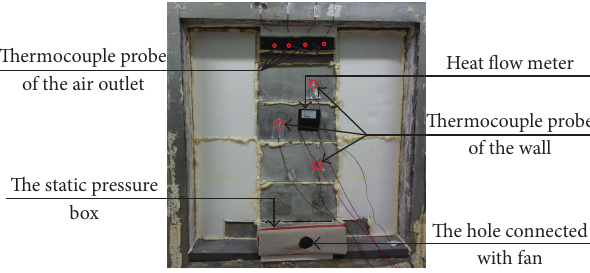
Figure 4: The arrange picture of thermocouple and heat flow meter.